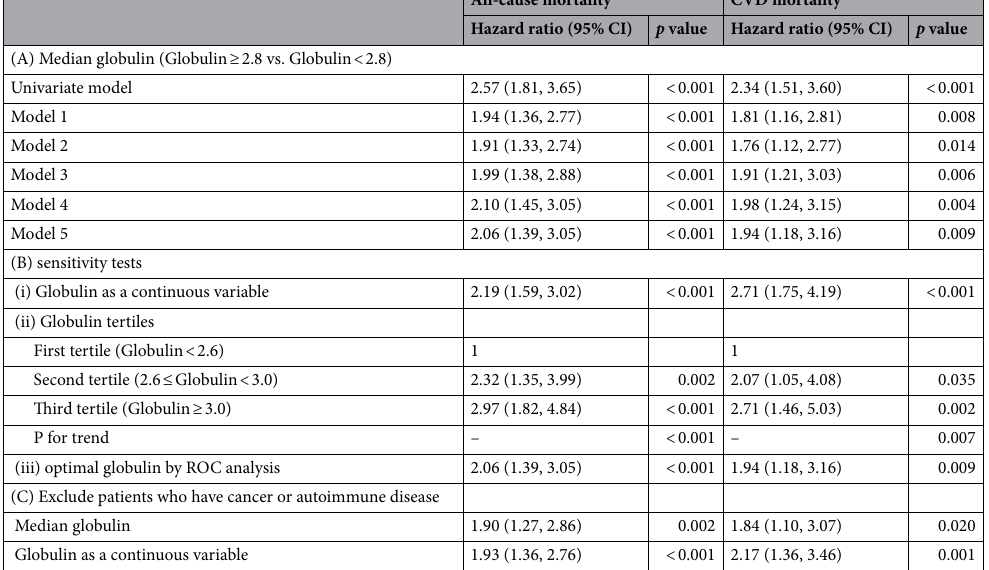
Table 2. Univariate and multivariate Cox regression models of mortality for the globulin groups. Model 1: globulin, age, sex, BMI, smoking status, the cause of chronic kidney disease, the status ahead of peritoneal dialysis and educational level. Model 2: Model 1 plus medications (ACE inhibitors/ARB, Diuretic, vitamin D, erythropoiesis-stimulating agents, and calcium channel blockers). Model 3: Model 2 plus comorbidities (diabetes mellitus, hypertension, hyperlipidemia, cancer, autoimmune disease and cardiovascular disease). Model 4: Model 3 plus PD related parameters (weekly total Kt/V urea, nPNA, D/P creatinine at 4 h, 24 h urine output, and residual renal function). Model 5: model 4 plus laboratory data (albumin, creatinine, alkaline- phosphate, GPT, WBC counts, hemoglobin, ferritin, cholesterol, triglyceride, intact PTH, calcium and phosphorus). The optimal cut-off value of globulin by ROC curve analysis is the same as the median globulin (2.8 mg/dL).